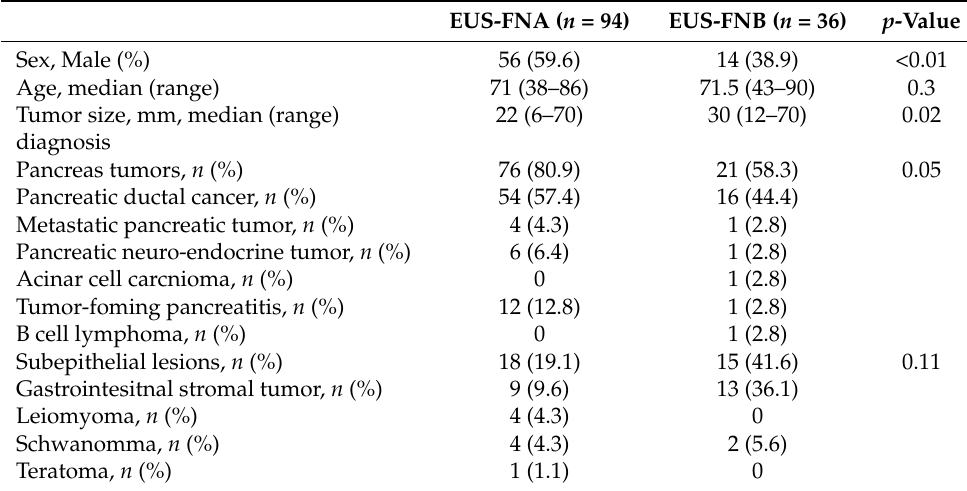
Table 1. Patient characteristics of EUS-FNA and EUS-FNB groups.